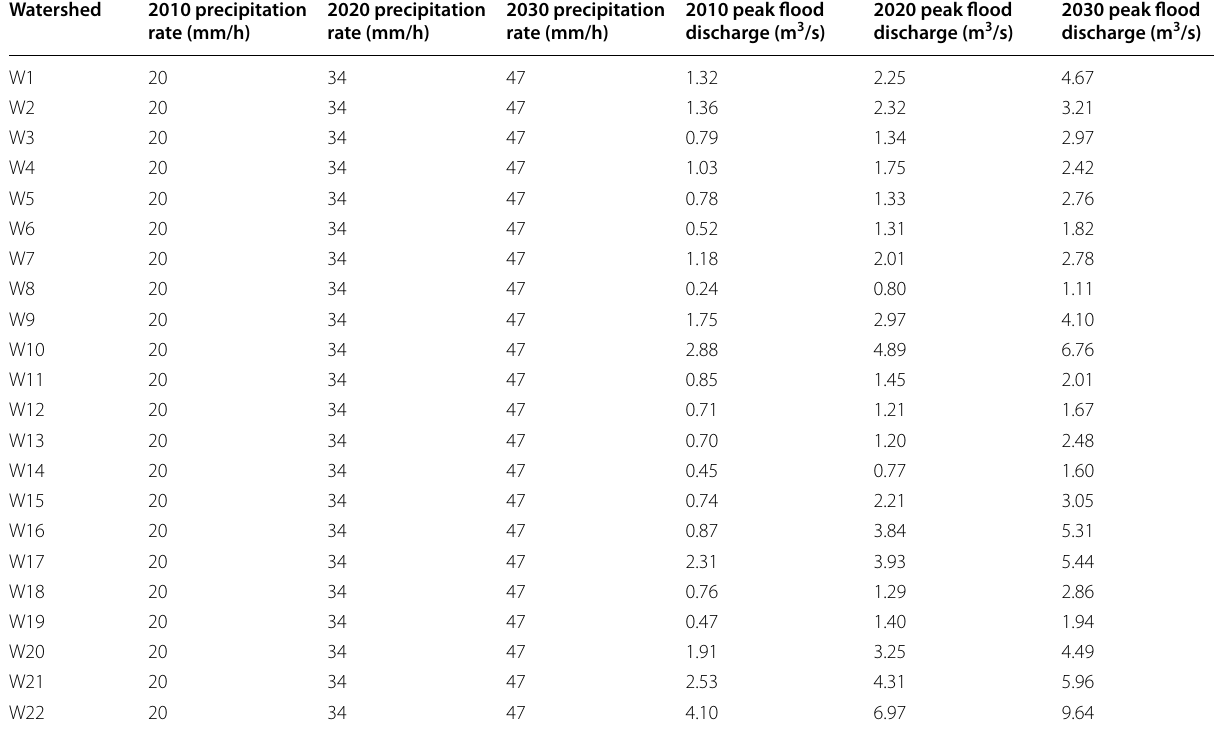
Table 4 Estimation of the maximum daily-precipitation rates and peak flood discharges in the watersheds within three periods